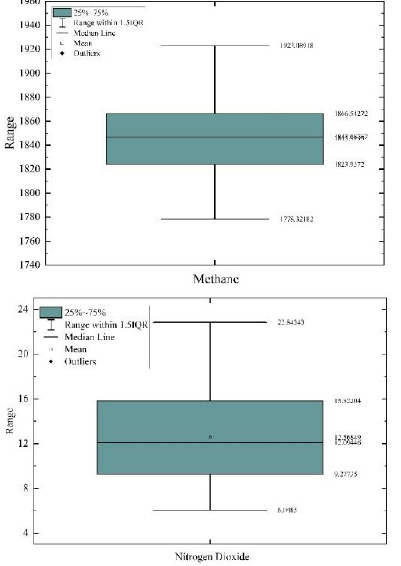
Figure 4: Box and whisker plot of Methane and Nitrogen dioxide after removing outliers using IQR.